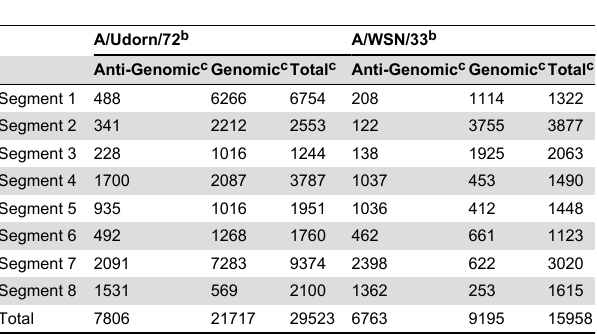
Table 2. Influenza A Virus Derived Sequence Tags a